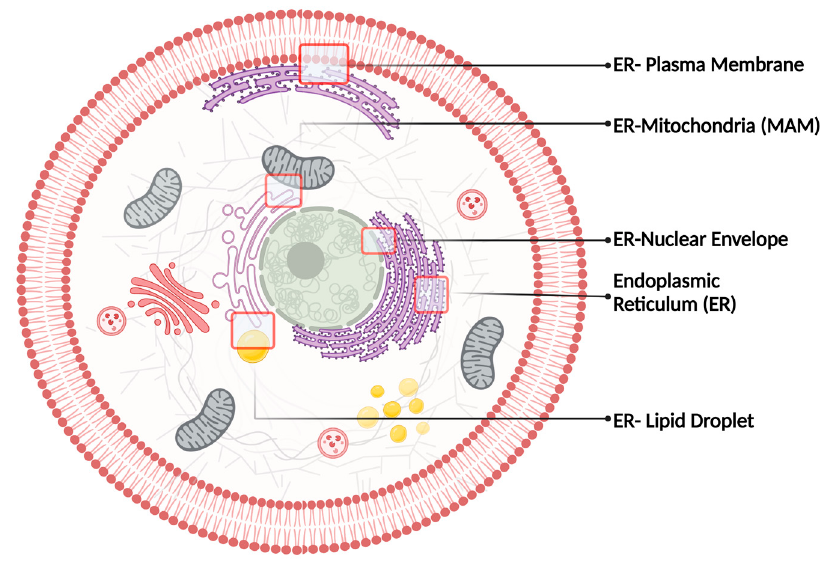
Figure 1. Intracellular membrane contact sites known to harbor S1R.